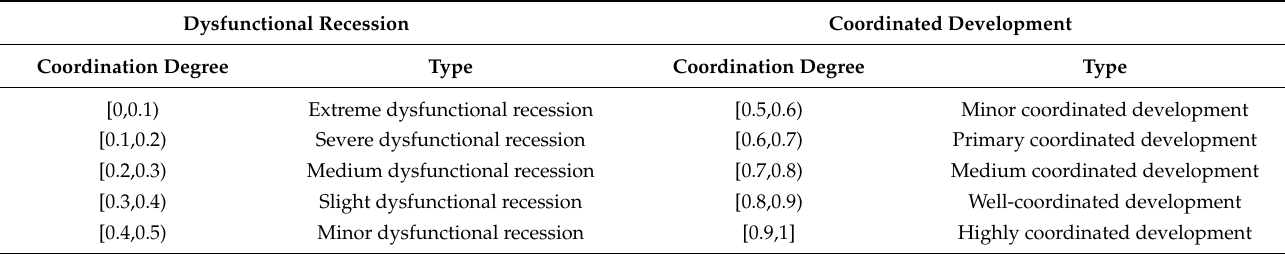
Table 2. Coordination degree